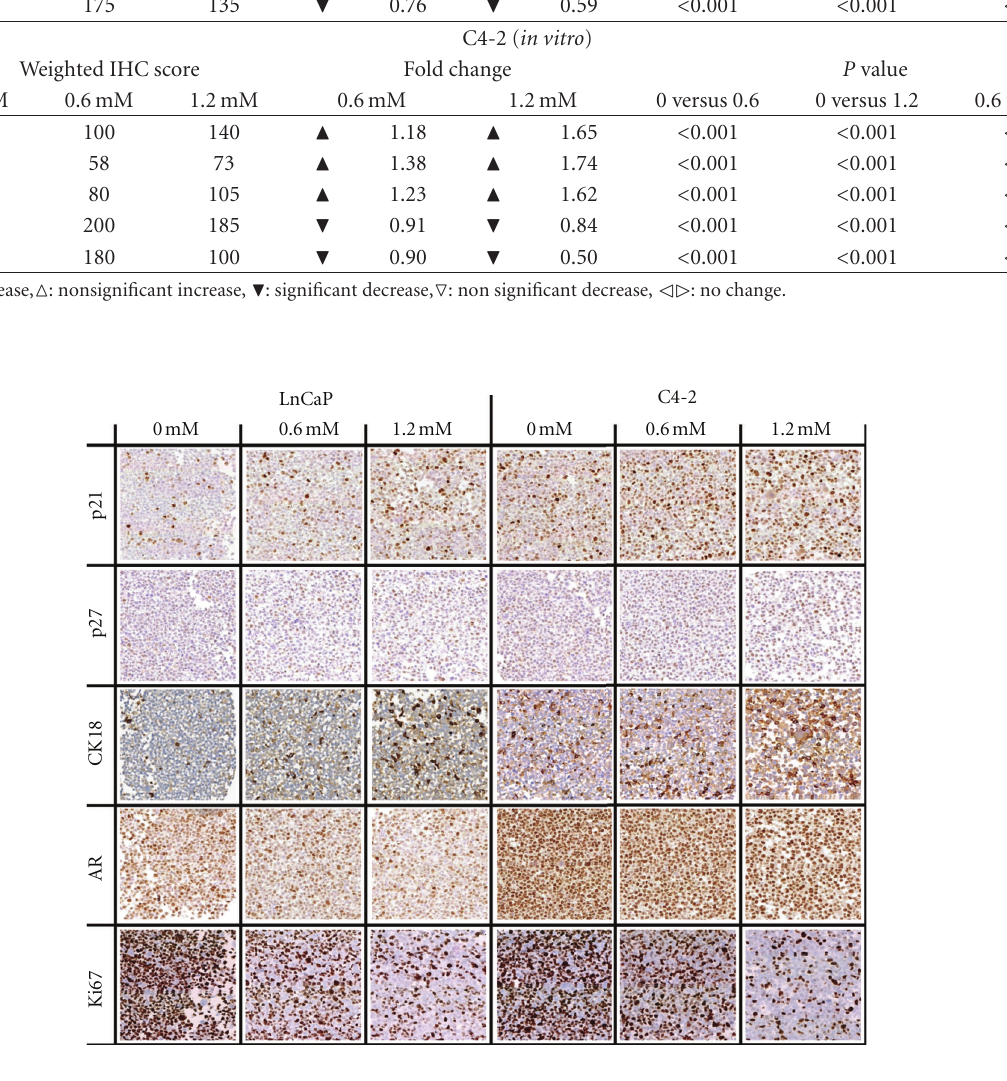
Figure 2: Cell lines (LNCaP, C4-2) were treated with 0, 0.6, and 1.2 mM of VPA for 14 days. TMA were created from cell pellets followed by IHC staining for expression of markers. Representative images of p21, p27, CK18, AR, and Ki-67 staining are shown (scanned at 20x magnification using the APERIO imaging